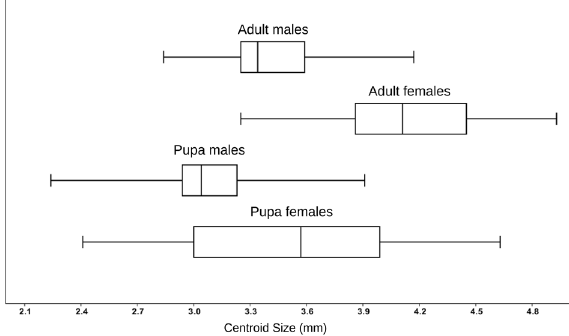
Figure 2. Box-plot diagram showing the centroid size sex differences between adult and pupa of Aedes albopictus.